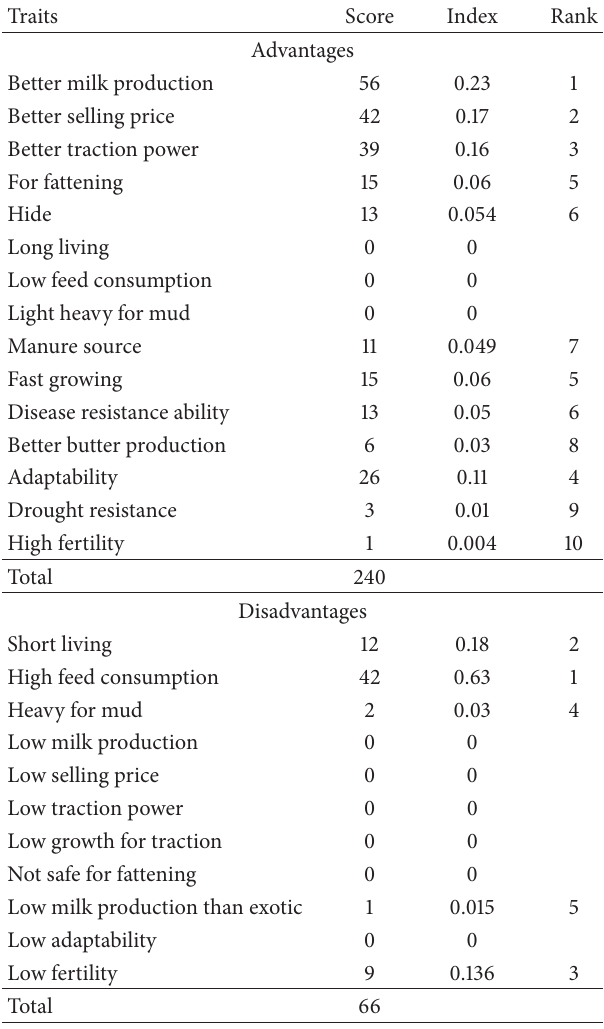
Table 3: Advantageous and disadvantageous traits of Fogera cattle breed.